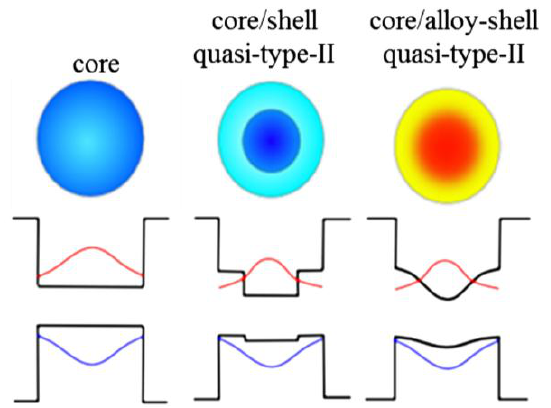
Figure 1. Different-type heterostructures (top row) and possible electron and hole wave-function distributions (bottom